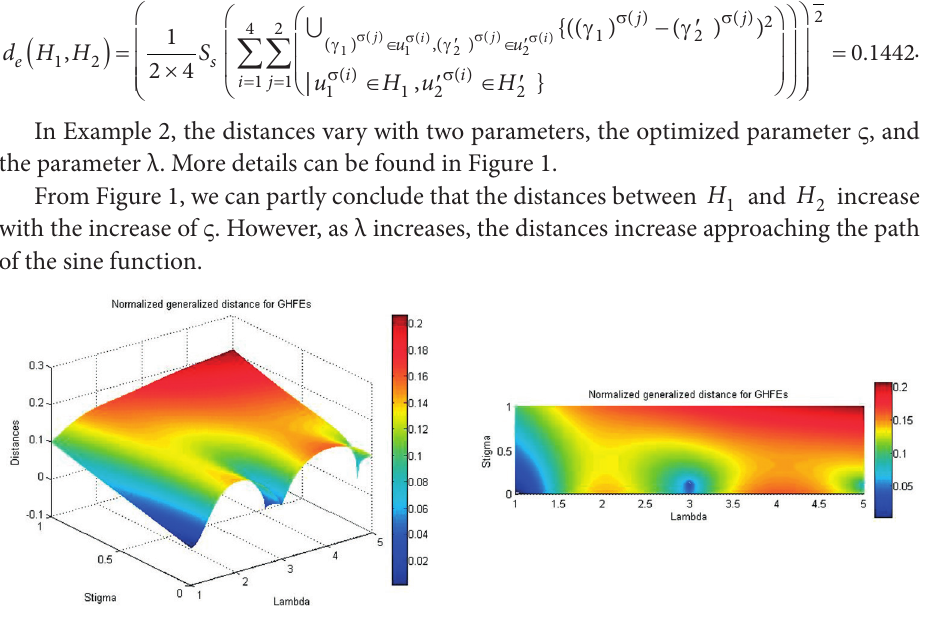
Fig. 1. Extended hesitant Normalized generalized distance ( [1,5], [0,1]) λ ∈ ς